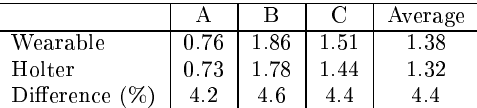
Table 4: Comparison of